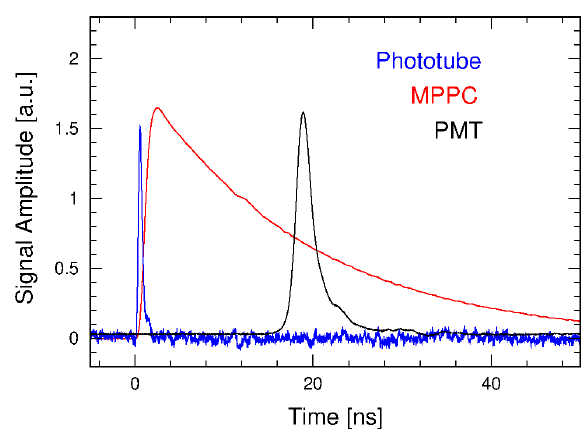
Fig. 6. Signal waveforms from photon detectors measured using the pulsed laser developed in this study. Average waveforms of 1000 events are shown. The vertical scales are adjusted to compare transit times of the detectors. The first peak is the signal from a phototube, the second one is from an MPPC, and the third one is a